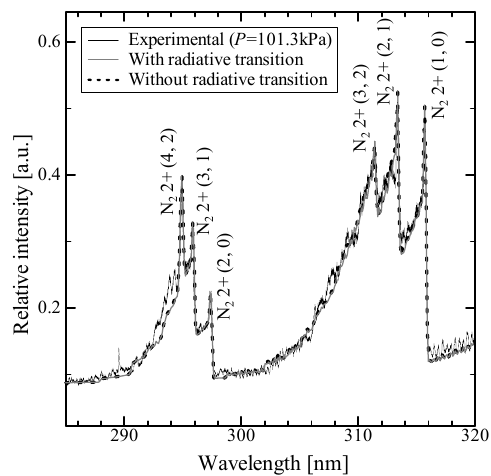
Fig. 9 Comparison of experimental and theoretical spectra at an atmospheric pressure